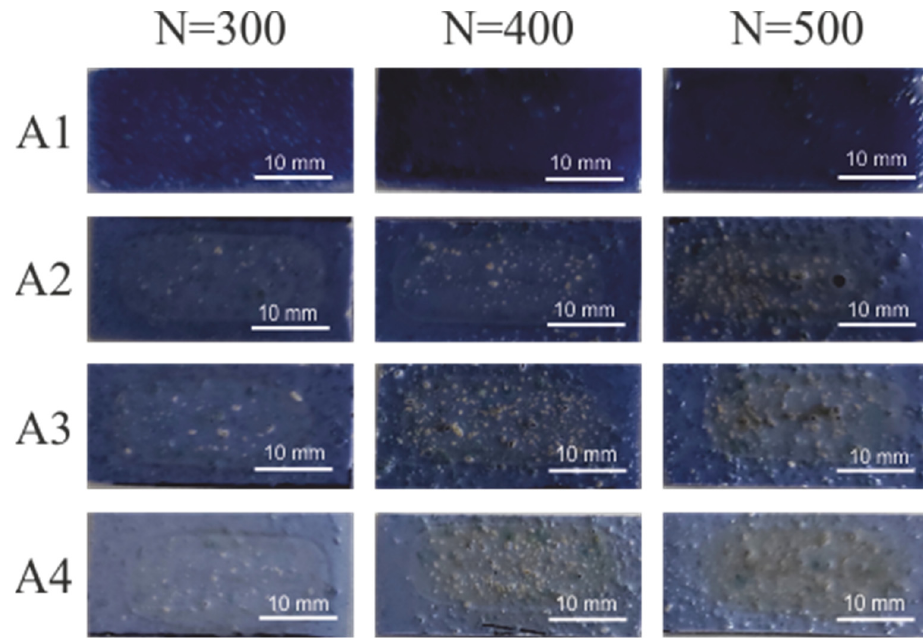
Figure 1. The effects of electroless metallization of A1–A4 coatings.